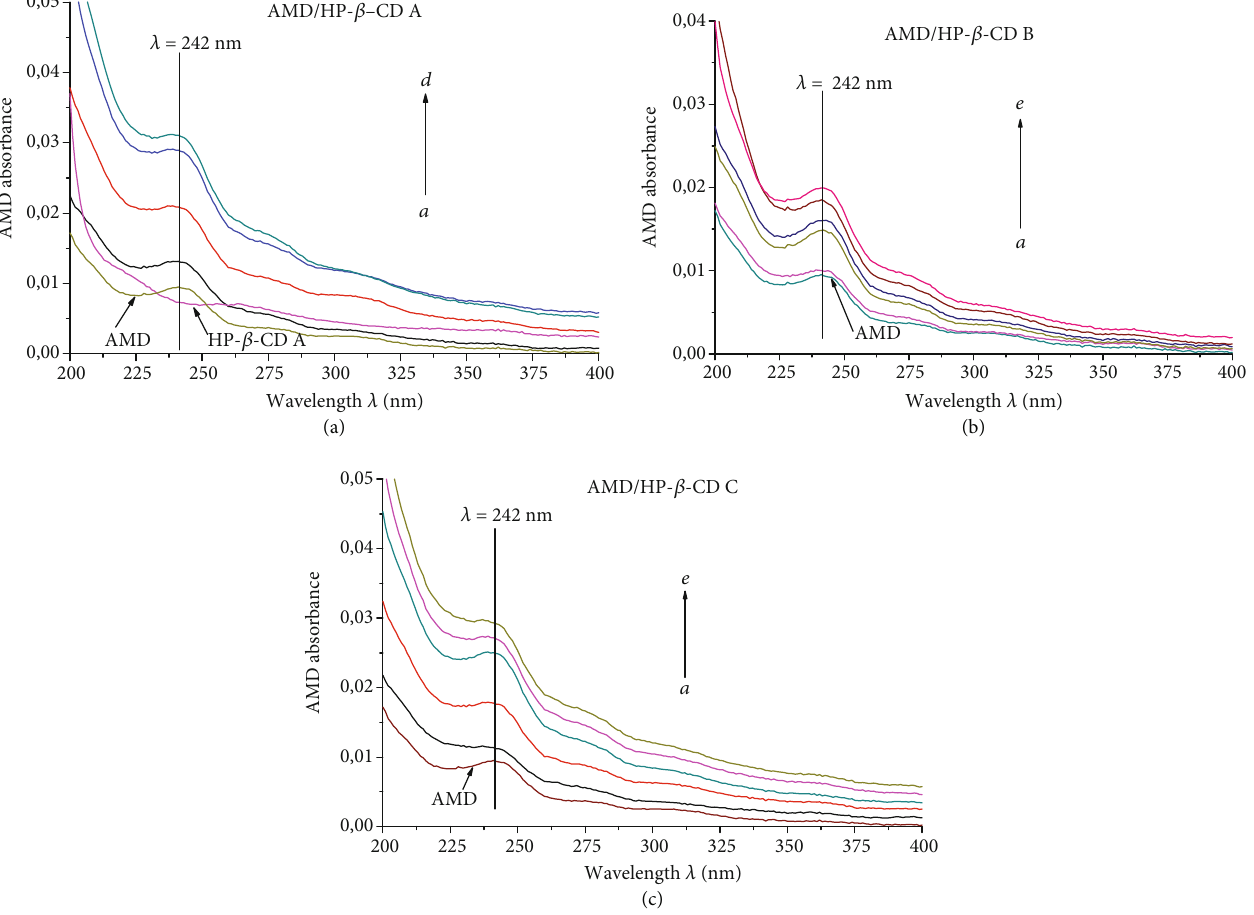
Figure 9: UV-VIS absorption spectra of AMD at constant concentration ( 0 : 018 × 10 ‐ 3 M in water) in the absence and presence of di ff erent concentrations of HP- β -CD. Curves a – e for concentrations of 0.4, 0.6, 2.0, 4.0, and 6.0mM of HP- β